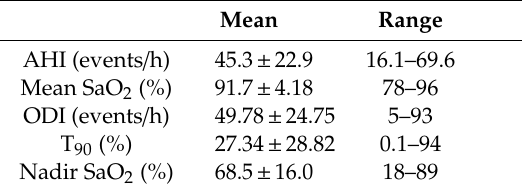
Table 2. Polygraphic recording indices.